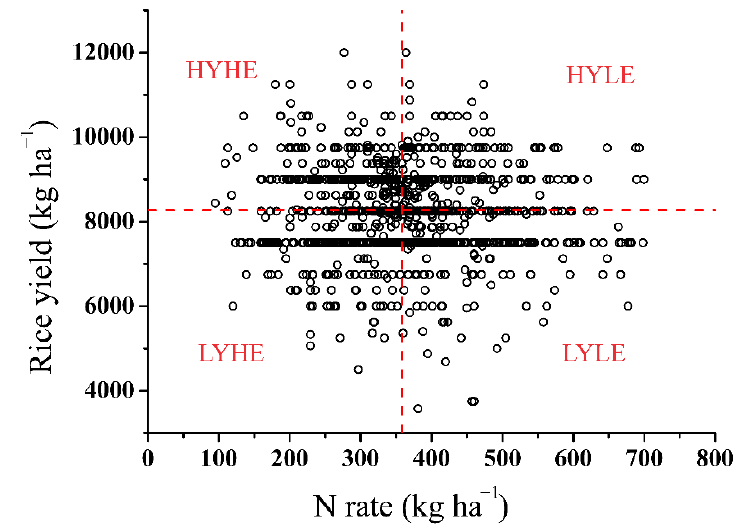
Figure 1. Criteria of four types (HYHE, HYLE, LYHE and LYLE) of farmers’ productivity level. Black circles represent the distribution of actual farmers’ yields in Jiangsu province. Data from farm surveys was conducted from 2008 to 2014. The red dotted lines reflect the production of rice is divided into four categories according to the average yield and N application rate. HYHE, HYLE, LYHE and LYLE represent high yield and high N use efficiency (NUE), high yield and low NUE, low yield and high NUE, and low yield and low NUE, respectively.